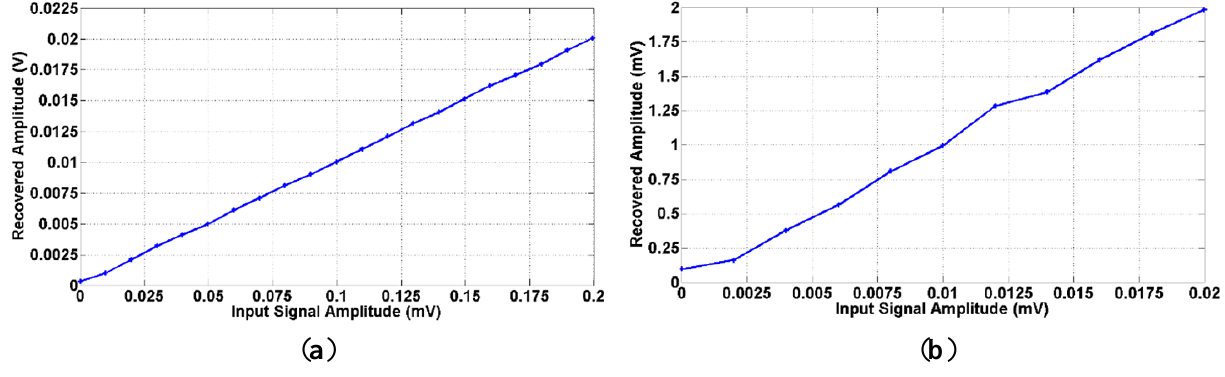
Figure 10. LIA experimental recovered input amplitude vs. input signal with amplitude values from ( a ) 1 μV to 200 μV and ( b ) 1 μV to 20 μV for a 10 kHz square input using a system gain of G =